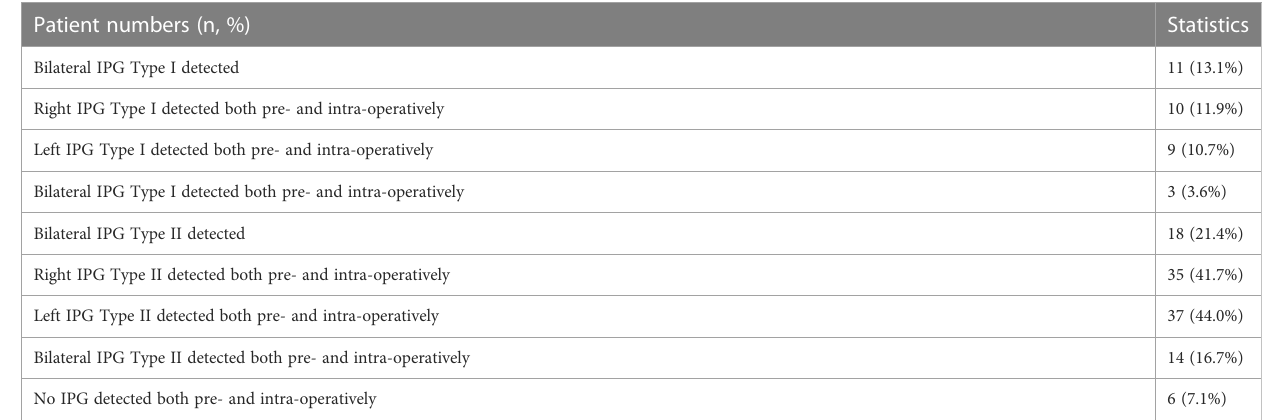
TABLE 5 IPG location types and detection